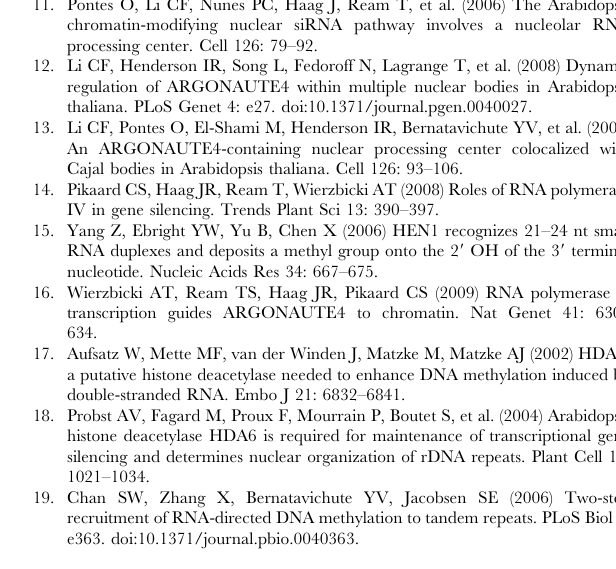
Figure S1 Sequence alignment of 5S-210 transcripts. Represen- tative sequence alignment of heterogenous 5S-210 transcripts from chromosomes 4 and 5 with the reference sequence from the same chromosome. Nucleotide positions diverging from the reference are in black box. The chromosome-specific T-stretch is in grey. Found at: doi:10.1371/journal.pgen.1000690.s001 (2.91 MB